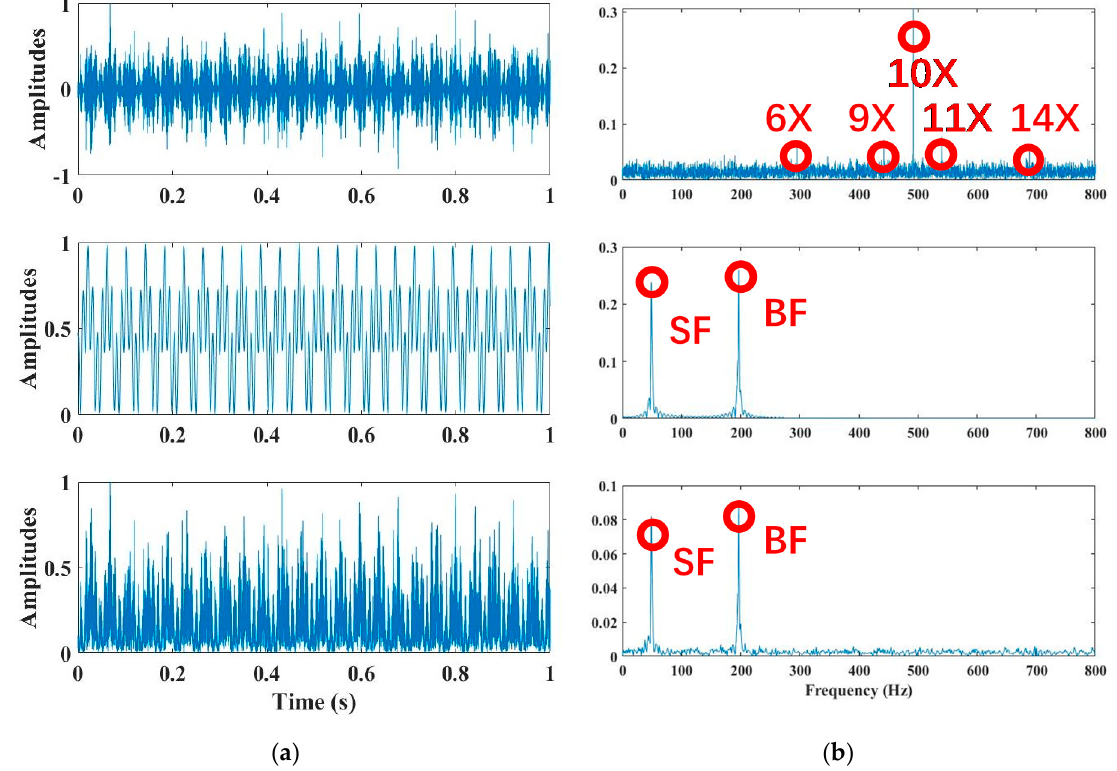
Figure 1. An example of the proposed cyclic amplitude model (CAM): modulation frequencies f 1 = 49.17 Hz (SF), f 2 = 4 × 49.17 Hz (BF = 4 × SF), and modulation amplitudes A 1 = A 2 = 0.5. Narrow band carriers f n = 10 × SF, and their amplitude B n = 0.3. C ( t ) is Gaussian white noise. ( a ) Simulated signal (top), autocorrelation (middle), and square-envelope (bottom); ( b ) power spectrum (top), autocorrelation spectrum (middle), and square-envelope spectrum (bottom). Note that the labels of the vertical axes represent the